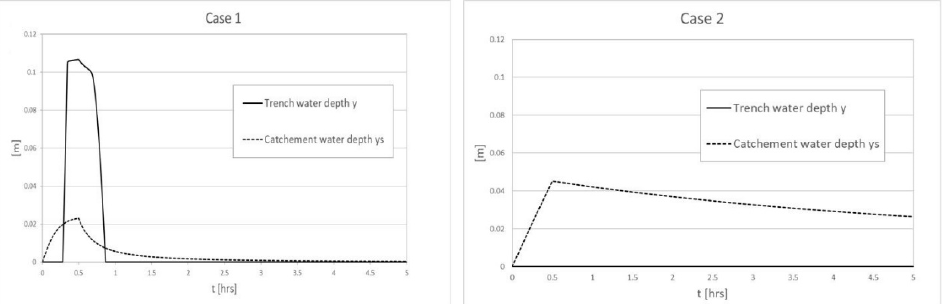
Figure 3. Estimated water depth on the runaway and over the infiltration trench as a function of time, generated by the design rainfall intensity j = 93 mm h − 1 with duration τ = 30 min and return time RT = 20 yrs, for the two proposed technical